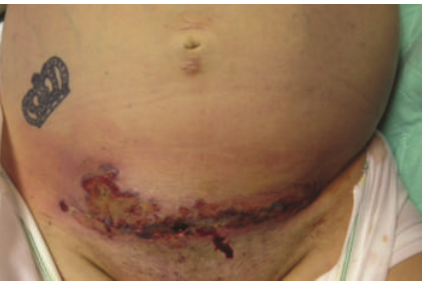
Figure 1: Abdominal examination on presentation to the tertiary care center on postoperative day